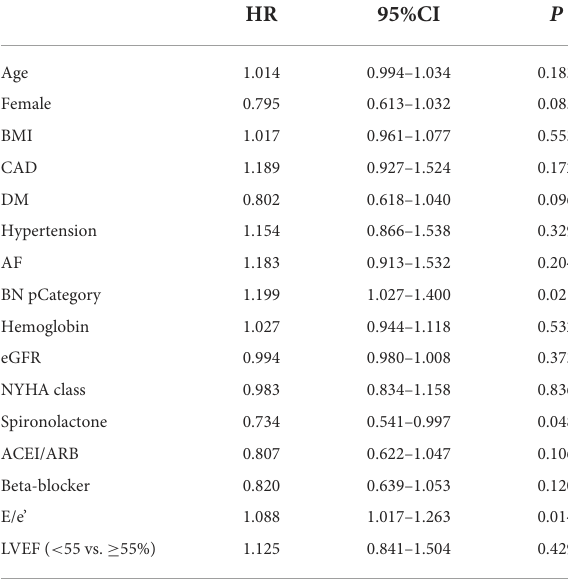
TABLE 4 Multivariable cox analysis for all-cause mortality in HFpEF patients with LVEF < 60%.